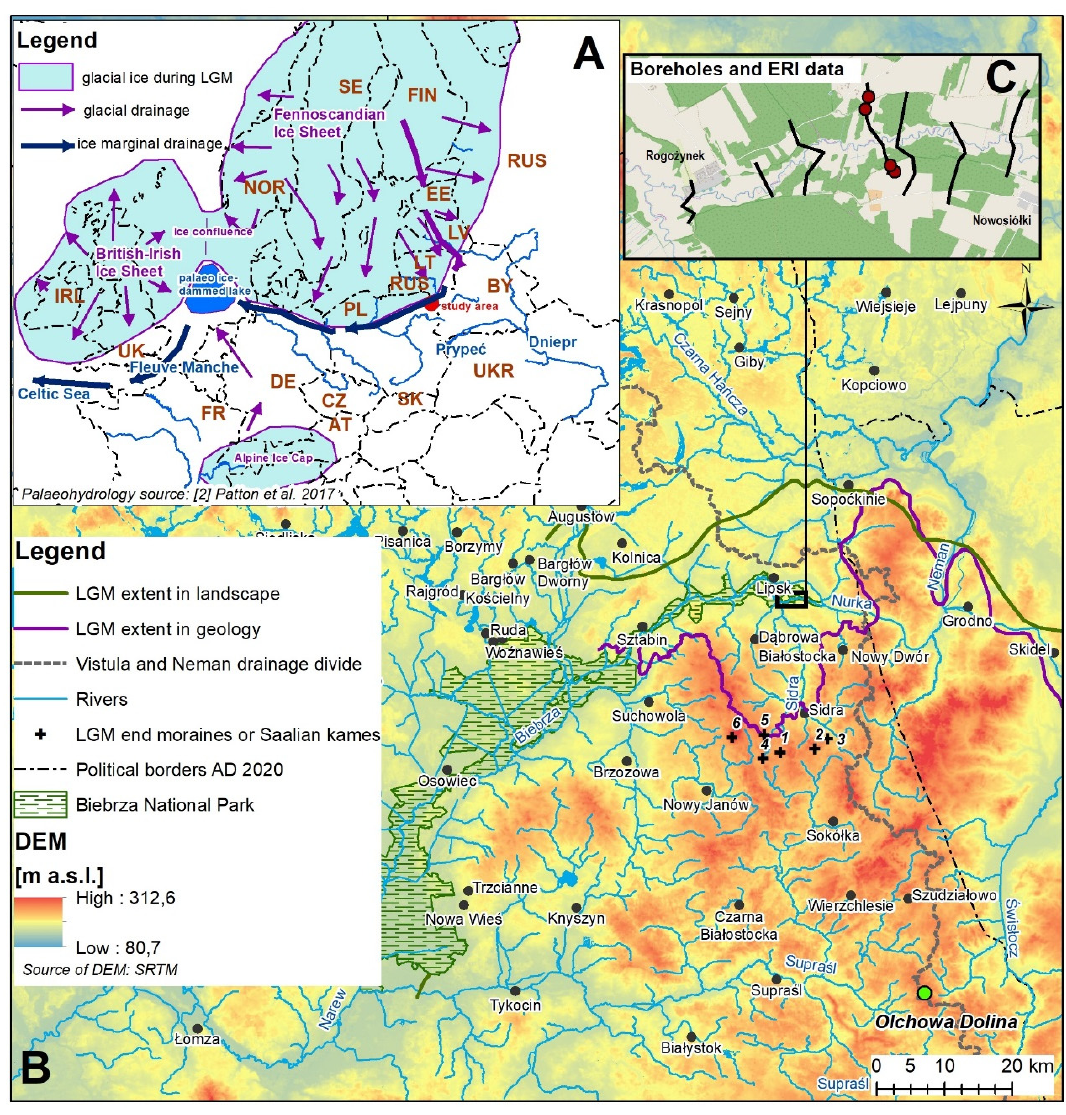
Figure 3. Study area. ( A ) Location on political map of Europe with paleohydrological setting during LGM [2]; ( B ) location on digital elevation model (DEM)–shuttle radar topography mission (SRTM) of NE Poland and adjacent parts of Lithuania and Belarus. LGM extent derived from: (i) landscape division (green line) [20,21], (ii) outcrops of Vistulian glacial till (purple line) [17,18,49] in Poland and [19] in Belarus. Black crosses are LGM terminal moraines [17,18,49] or Saalian kames [16]: 1—G ó ra Basielowa (218.2 m ASL), 2—G ó ra Sygnały (214.1 m ASL), 3—G ó ra Łokietka (191.2 m ASL), 4—G ó ra Sotniczka (192.6 m ASL), 5—W ó lcza´nskie G ó ry (213 m ASL), 6—Karpackie G ó ry (229.2 m ASL); ( C ) location of boreholes (red dots) and ERI profiles (black lines) in the Upper Biebrza valley between Rogo˙zynek (Lipsk Municipality, August ó w County) and Nowosi ó łki (Nowy Dw ó r Municipality, Sok ó łka County) settlements on OpenStreetMap.